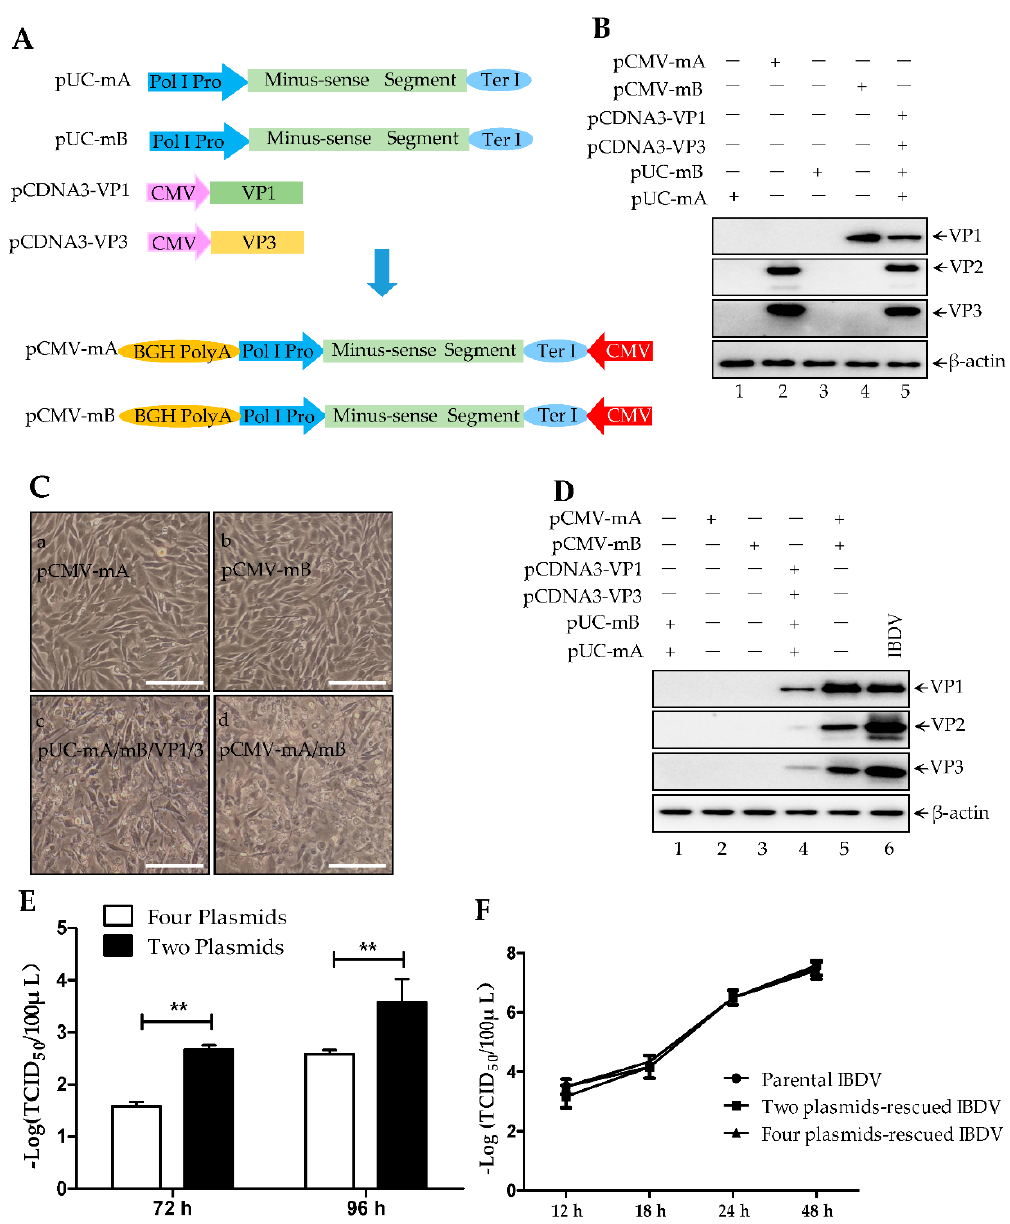
Figure 3. Dual-direction promoter improves virus rescue efficiency. ( A ) The model of an IBDV rescue system with four plasmids (Upper) and two plasmids (Bottom). The full length of the sequence through Poly I Pro to Ter I in the plasmid of pUC-mA and pUC-mB was inserted into the pCDN3.0 vector, named as pCMV-mA and pCMV-mB. ( B ) Indicated plasmids were co-transfected into 293T cells for 72 h. The cell lysates were subjected to western blot for detecting viral proteins, including VP1–VP3. ( C ) The supernatant of transfected cells indicated plasmids were transferred into monolayer DF-1 cells for culturing for another 48 h. CPE was observed under the phased-phage microscopy. Scale bars, 100 μm. ( D ) The supernatant of transfected cells in Figure 3C were transferred into monolayer DF-1 cells for culturing for another 24 h. Then, viral proteins were further examined by western blotting using indicated antibodies. ( E ) Supernatant of 293T cells (in 6-well plate) transfected with pUC-mA and pUC-mB plus both VP1 and VP3, or pCMV-mA and pCMV-mB for 72 h and 96 h. Collecting the whole cells for TCID 50 to detect the virus titers in the supernatant. The data were presented as means ±SD with three independent experiments, ** p < 0.01. ( F ) DF-1 cells infected with 0.1 MOI of different IBDV strains, including two plasmids recued, four plasmids rescued, and parental IBDV at 12 h, 18 h, 24 h, and 48 h. Collecting the whole cells for TCID 50 to detect the virus titers in the supernatant.